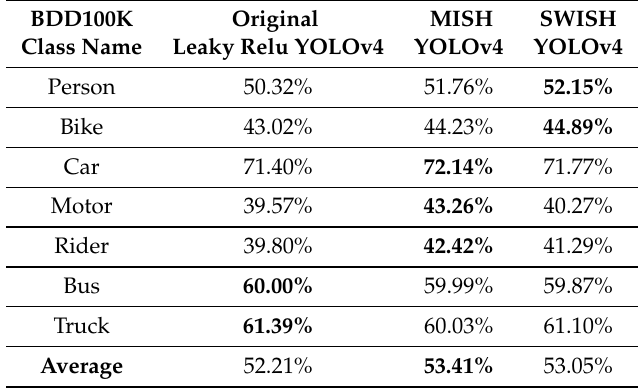
Table 6. AP50 for each class with YOLOv4 different activation functions trained with BDD100K when applied to the BDD100K test subset.